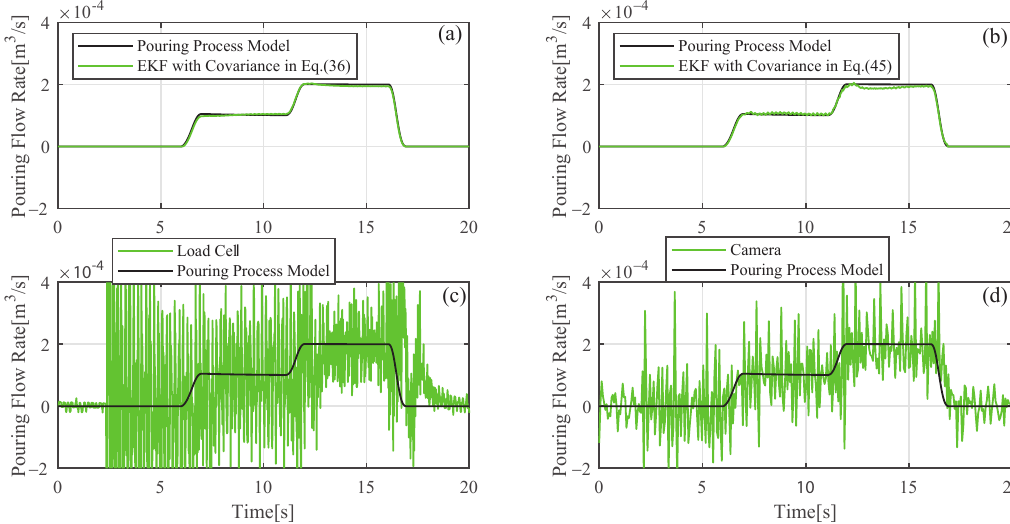
Figure 18. Comparison of flow-rate estimations in experiments with tilting angle error at the start of liquid outflow: + 0 deg. ( a ) Estimated flow rate by EKF with covariance as shown in Equation (37); ( b ) Estimated flow rate by EKF with covariance as shown in Equation (46); ( c ) Estimated flow rate by differentiating weight of outflow liquid measured by load cell; ( d ) Estimated flow rate by visible